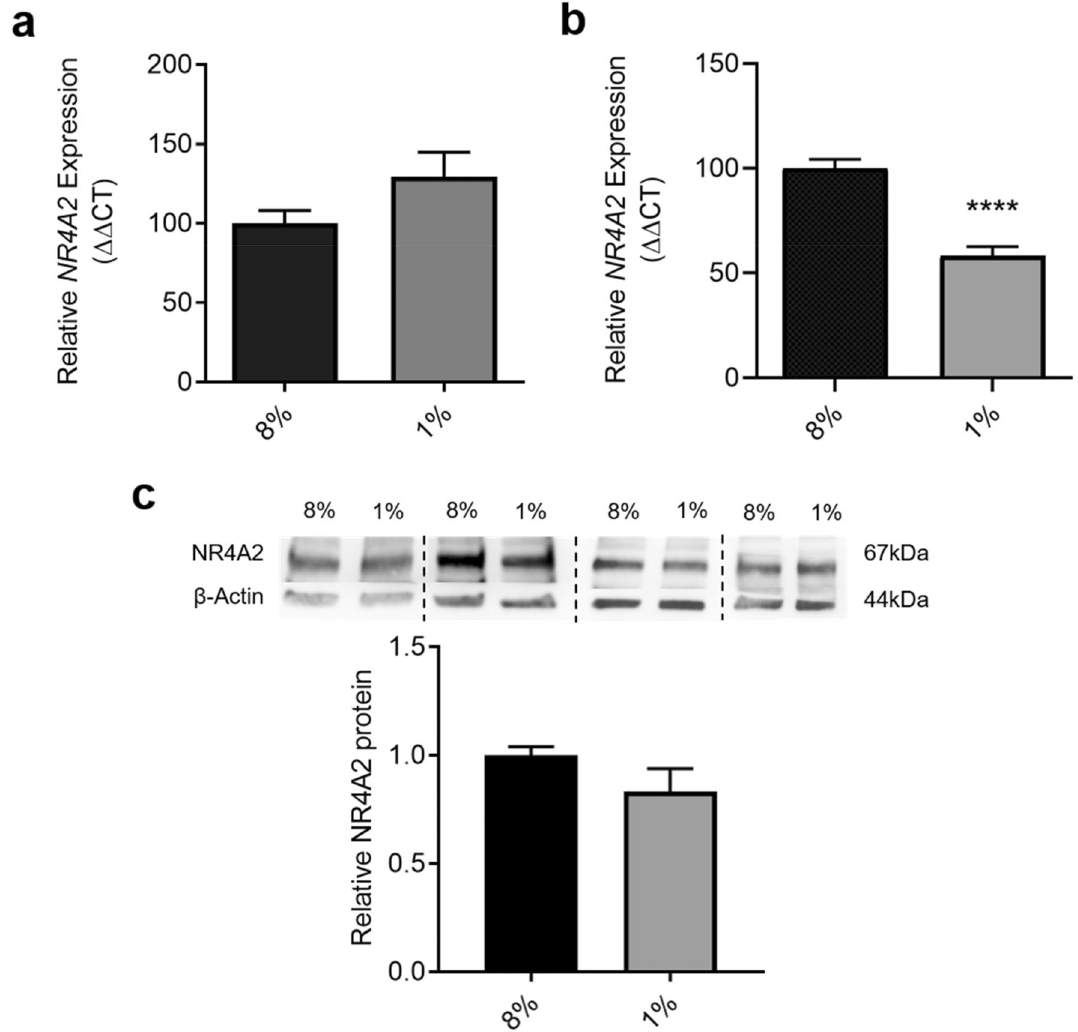
( b ). There was no change in NR4A2 protein production with hypoxia ( c ). Data presented as fold change from control ± SEM. qPCR: n = 4–5 experimental replicates, each sample from a different patient. Each sample was run in triplicate. Western blot: n = 4 experimental replicates, with each sample from a different patient. Each experiment was run in triplicate and replicate lysates were pooled. β-actin acted as the loading